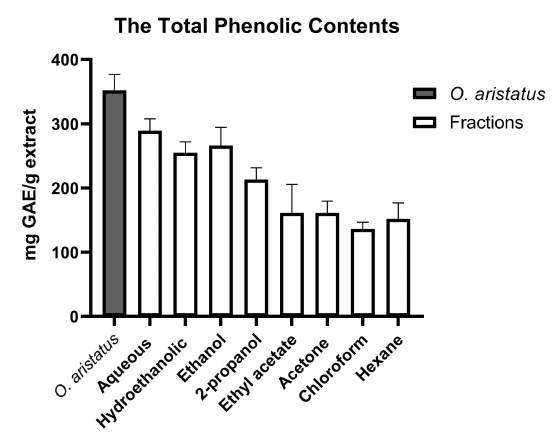
Figure 1. Total phenolic contents of O. aristatus extract and its fractions. Values were presented as mean ± SD, n = 3.